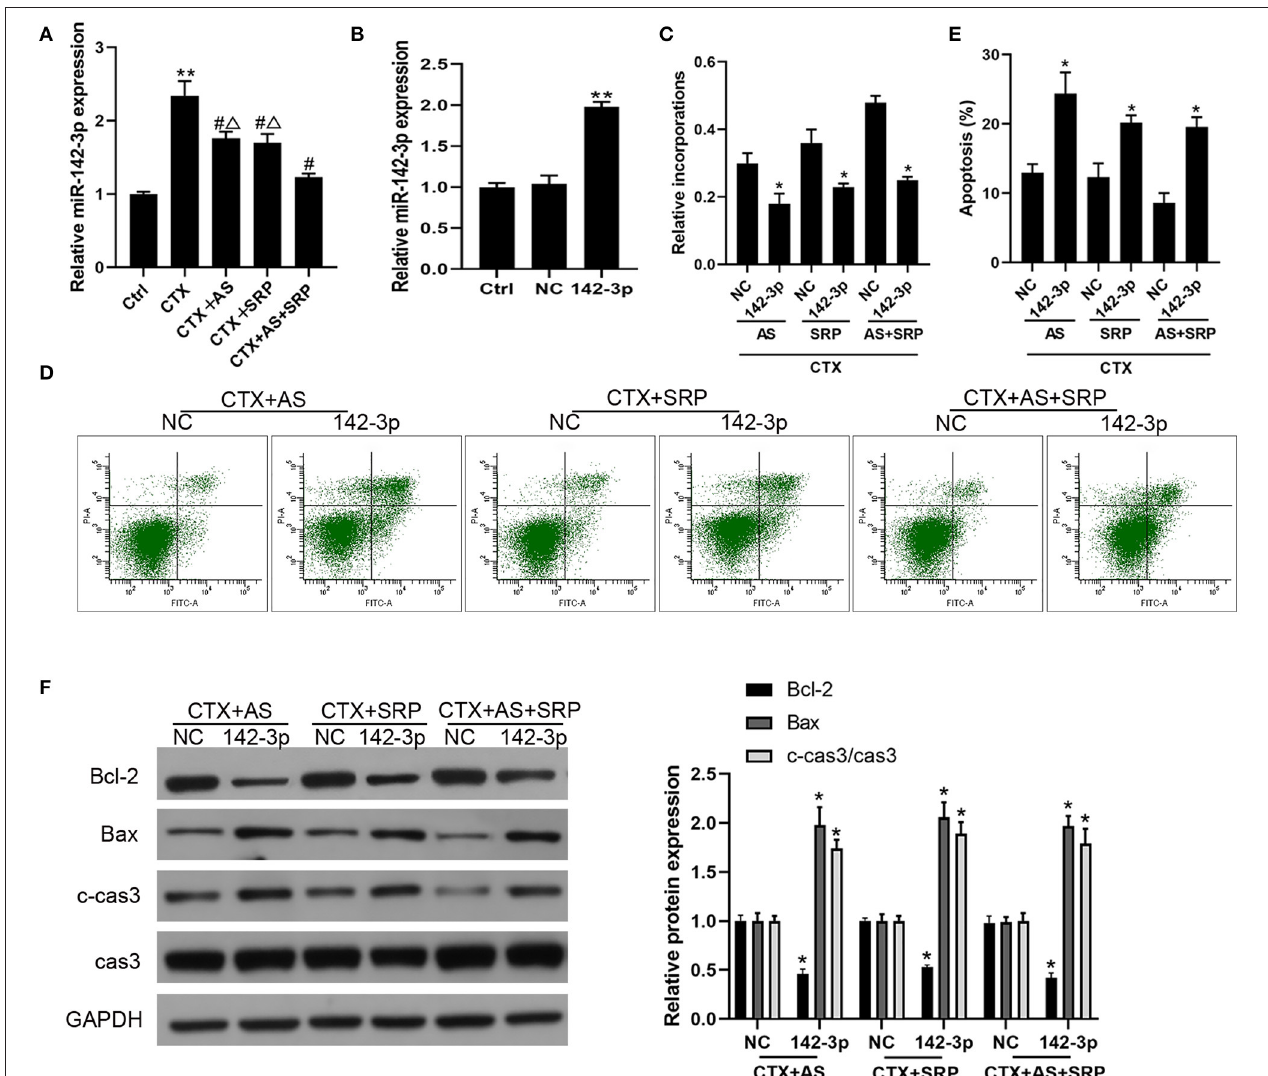
FIGURE 2 | Over-expression of miR-142-3p abolished the inhibitory effect of Astragaloside IV (AS) and saponins of rhizoma polygonati (SRP) on CTX-induced cell injury in bone marrow hematopoietic stem cells (BMHSCs). (A) BMHSCs were treated with 20 µ M CTX, 20 µ M CTX + 5 µ M AS, 20 µ M CTX + 10 µ M SRP, or 20 µ M CTX + 5 µ M AS + 10 µ M SRP for 48h. The expression of miR-142-3p was detected by RT-qPCR. (B) After transfection with miR-NC or miR-142-3p mimic, the expression of miR-142-3p was detected by RT-qPCR. (C) Cell proliferation was measured by BrdU assay. (D,E) Cell apoptosis was detected by Annexin V-PI staining. (E) Protein expressions of Bcl-2, Bax, and c-cas3/cas3 were determined by Western blot. ** P < 0.01 vs. Ctrl group; * P < 0.05 vs. NC group; # P < 0.01 vs. CTX alone group; 1 P < 0.05 vs. CTX + AS + SRP group; n =